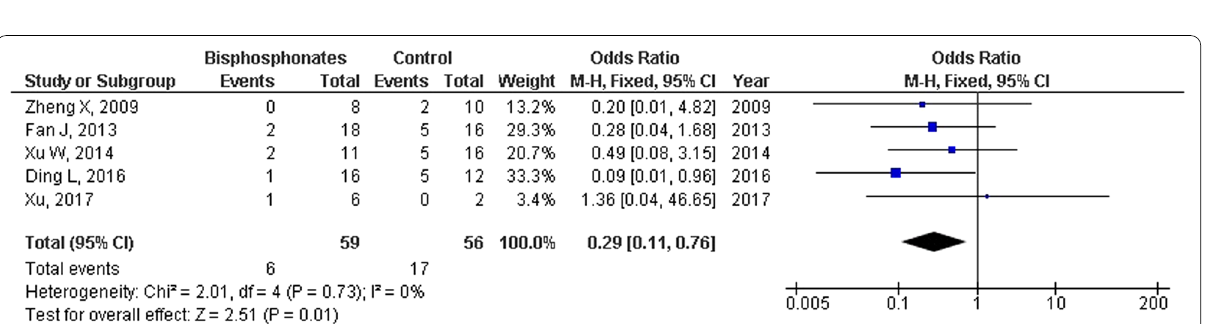
Fig. 3 The forest plot of how bisphosphonates affect postoperative recurrence outcomes in patients with stage I–II giant cell bone tumors as compared to controls